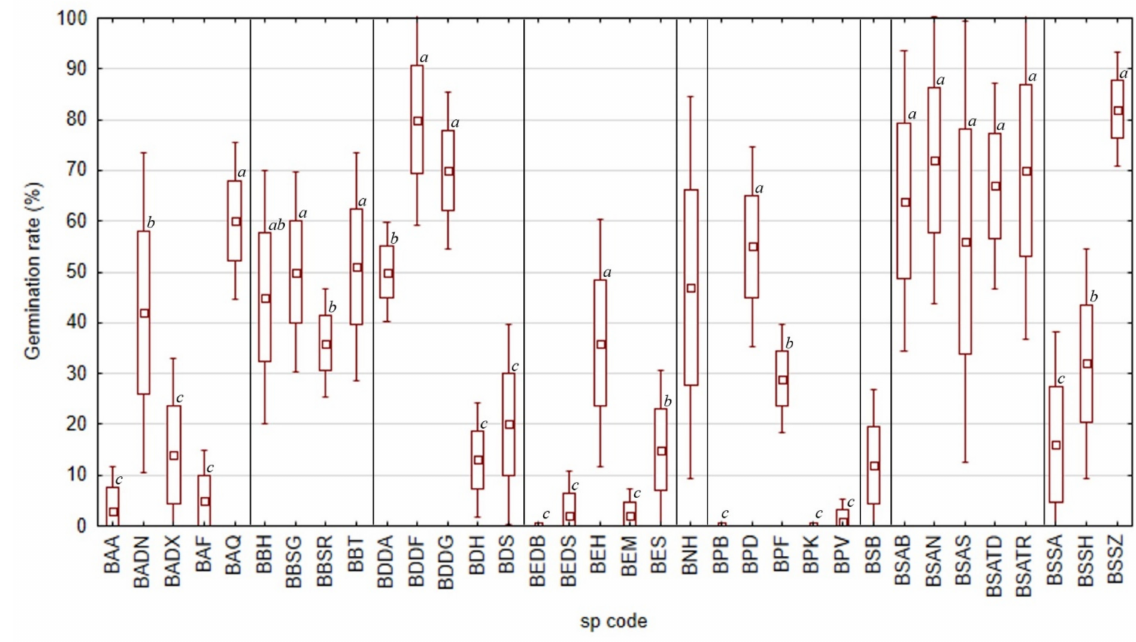
Figure 3. Seed germination rate of all nine taxa of Boswellia from different localities in 2021 on Socotra Island (a, b, c—Indexes denoting localities with significantly separate germination rates within individual taxon, the same index associates the seed without statistically significant difference in germination